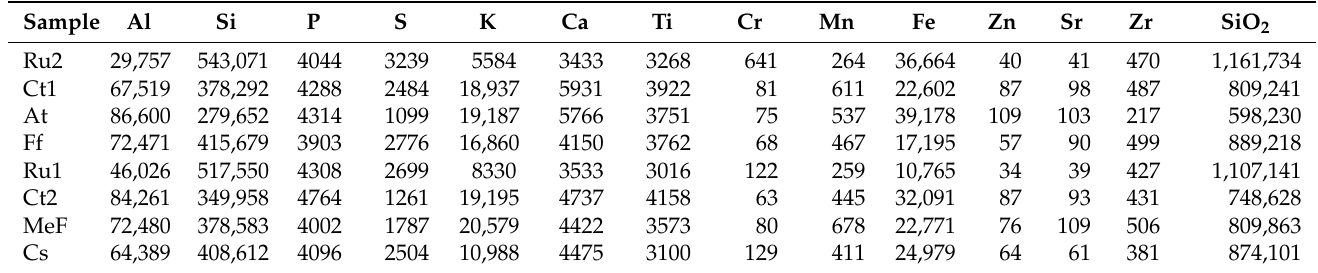
Table 2. Sample solid-phase elemental total concentrations (mg/kg) from XRF analysis.